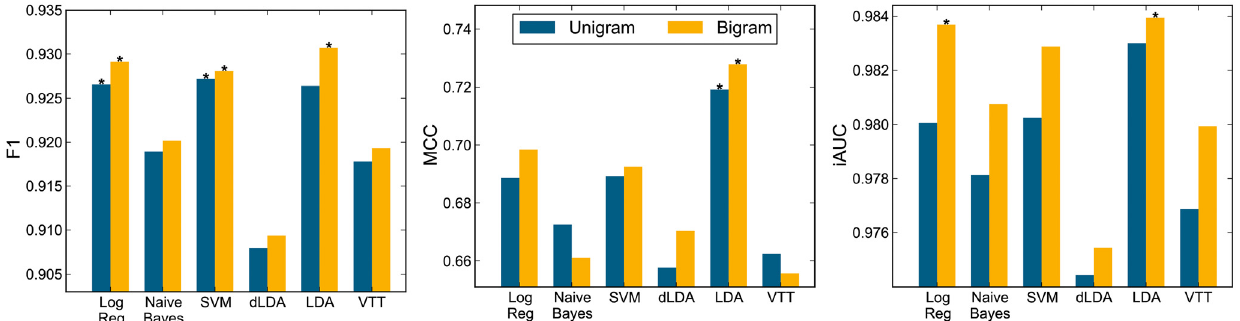
Fig 2. Classification performance on abstracts. Performance for both unigram and bigram runs on non-transformed features. Left: F1 measure. Middle: MCC measure. Right: iAUC measure. The best classifier configuration, and configurations not significantly different ( p > 0.05, one-tailed test) from it, marked with asterisk ‘ * ’